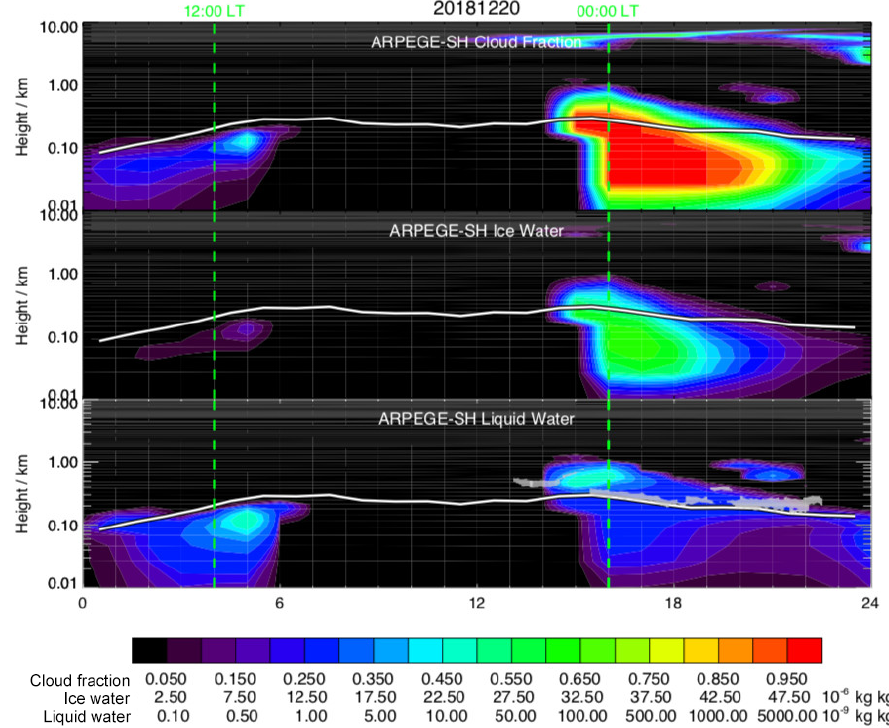
Figure 10. Same as Fig. 3 but for 20 December